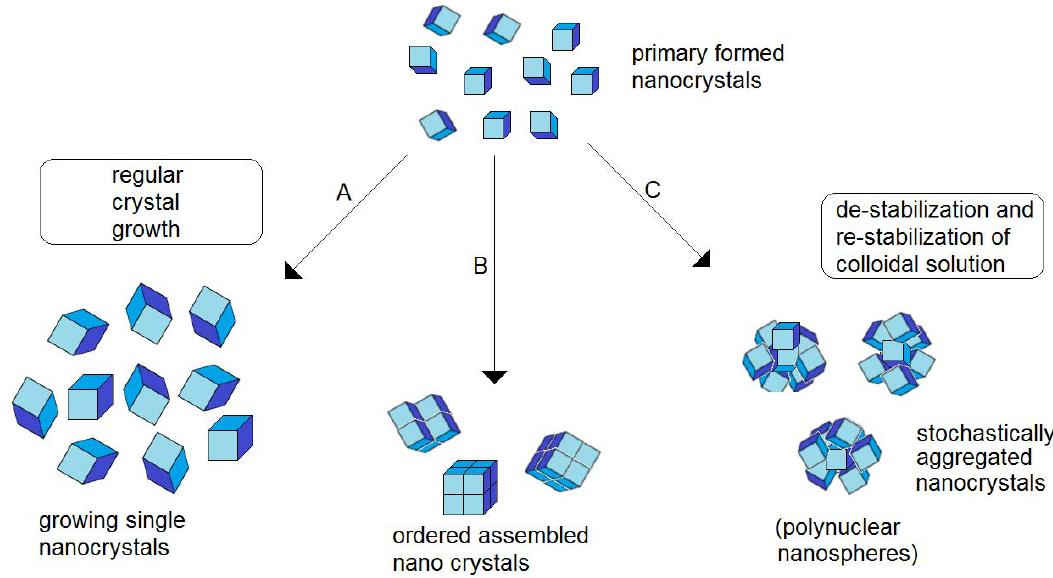
Figure 4. Potential-dependent behavior of forming metal nanoparticles in colloidal solution (schematically): Single crystals are obtained if stronger repulsive forces and/or solvation inhibit the interaction and agglomeration of particles (A), more or less regular particle assemblies can be obtained in case of an aggregation with a partial surface mobility of assembling components (B), stochastic aggregation without mobility causes the formation of irregular composed particles which might be self-stabilized above a critical particle size (C). Ongoing metal deposition leads to the formation of nearly spherical polynuclear nanoparticles [8].